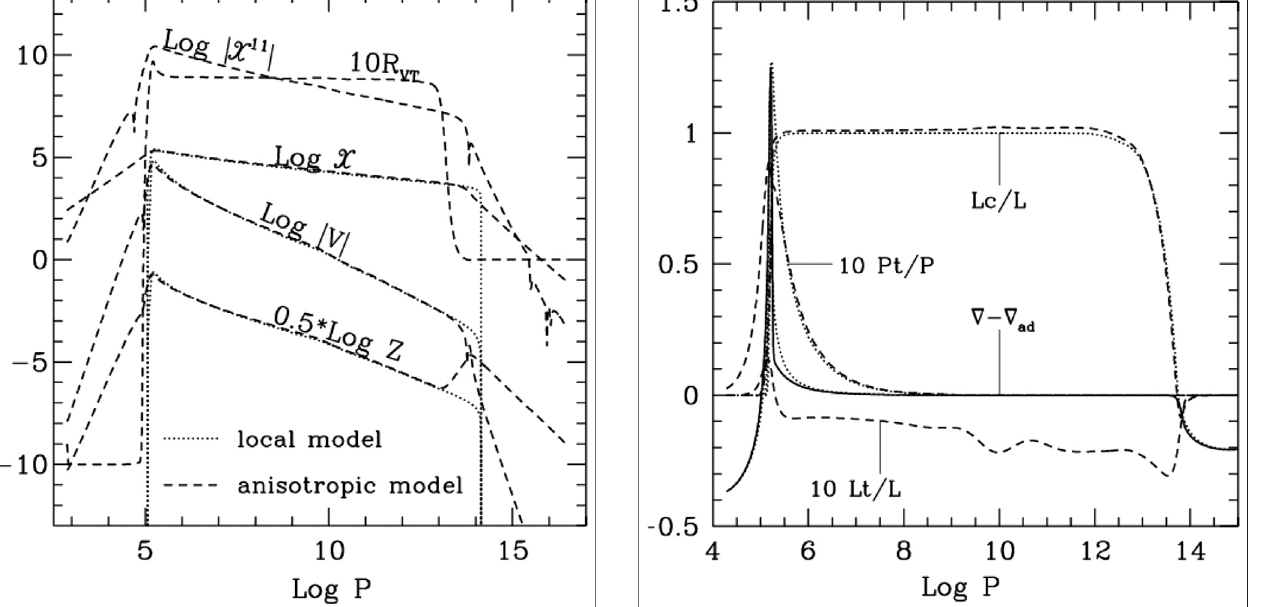
FIGURE 1 | Auto- and cross-correlations of turbulent velocity and temperature, x , χ ij ( Eq. 17 ), Z ( Eq. 22 ), and V ( Eq. 23 ) versus log P for the local (dotted-lines) and non-local (dashed-lines) convective models of the Sun having the same convection zone depth.